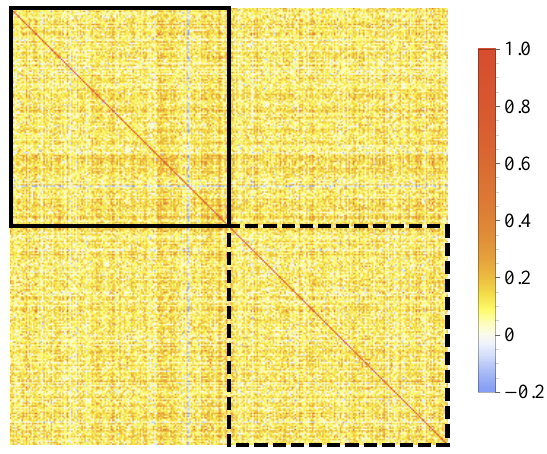
Figure 10. Heterogeneous correlation matrix illustrating a financial market. The two rimmed squares correspond to two non-overlapping credit portfolios. Taken from (Sicking et al.